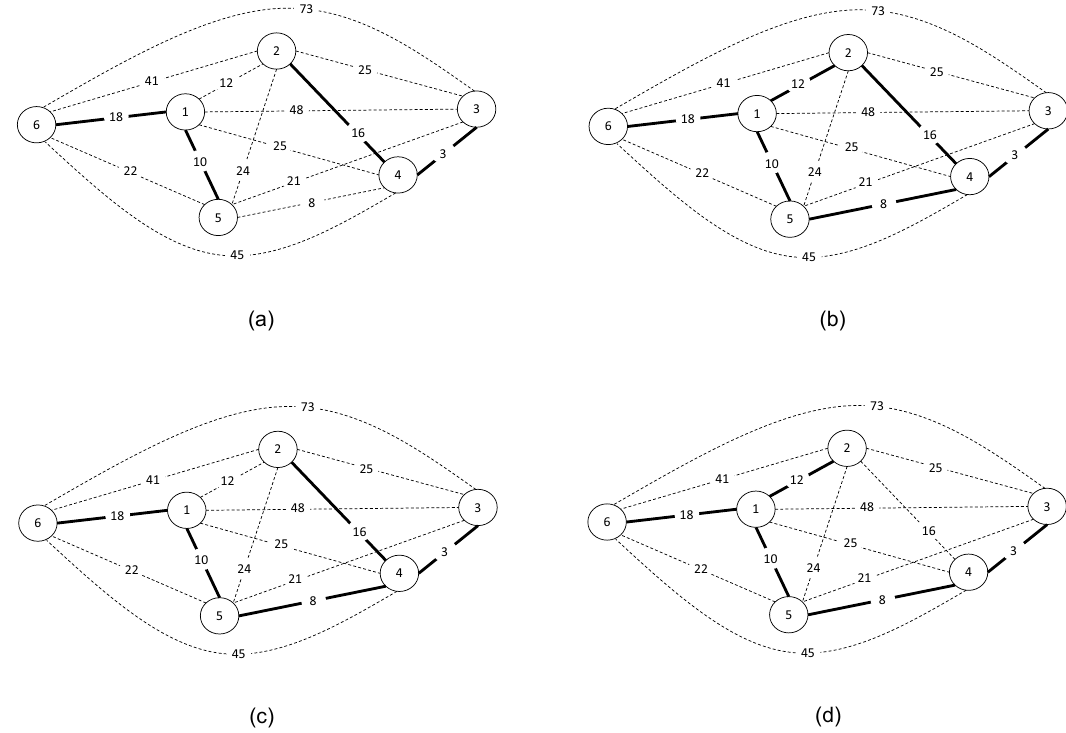
Figure 2. Subsets of selected arcs connecting nodes in the sample network of Figure 1: ( a ) selected arcs are not sufficient to form a spanning tree that connects all nodes; ( b ) selected arcs are spanning all nodes but they form a cycle; ( c ) selected arcs form a spanning tree that does not have the minimum total arc length; and ( d ) selected arcs form a minimum spanning